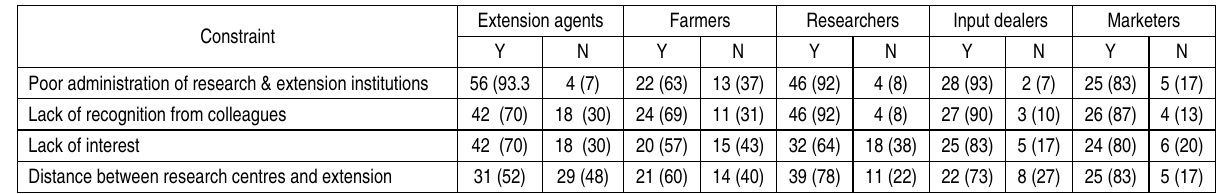
Table 2 (cont.). Constraints to collaboration faced by extension agents, farmers, researchers, input dealers